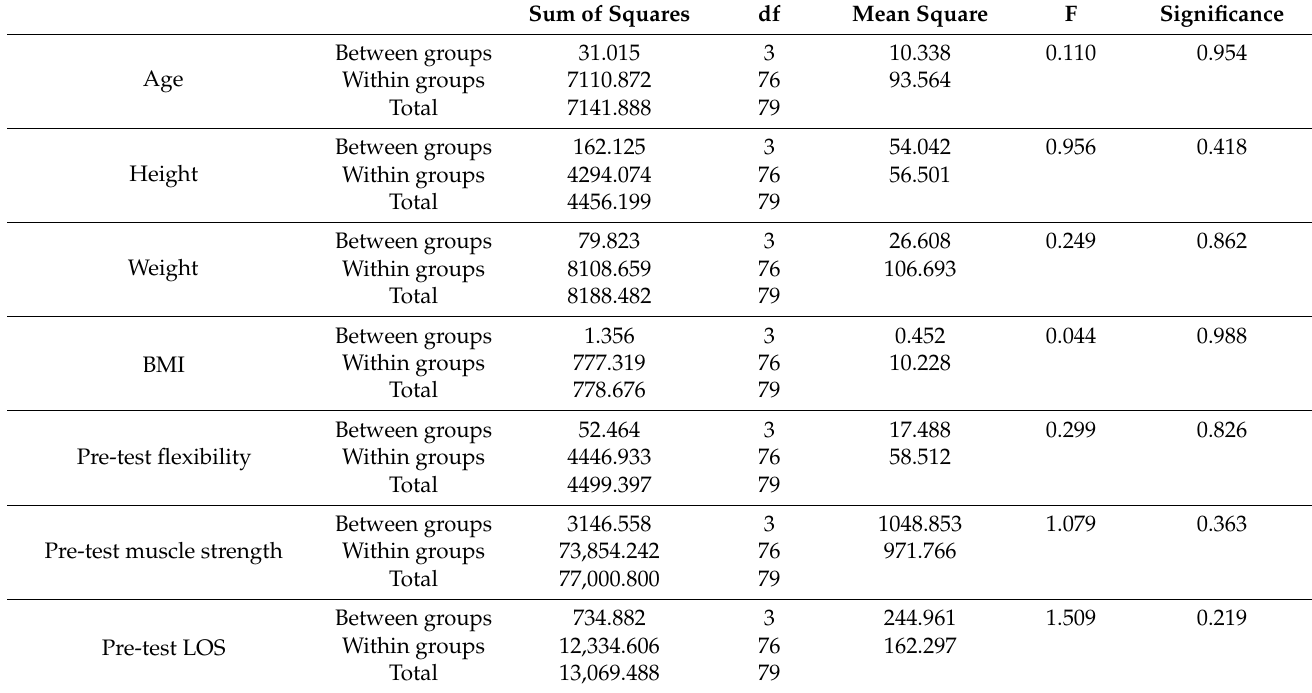
Table 1. ANOVA Table 1. ANOVA results.